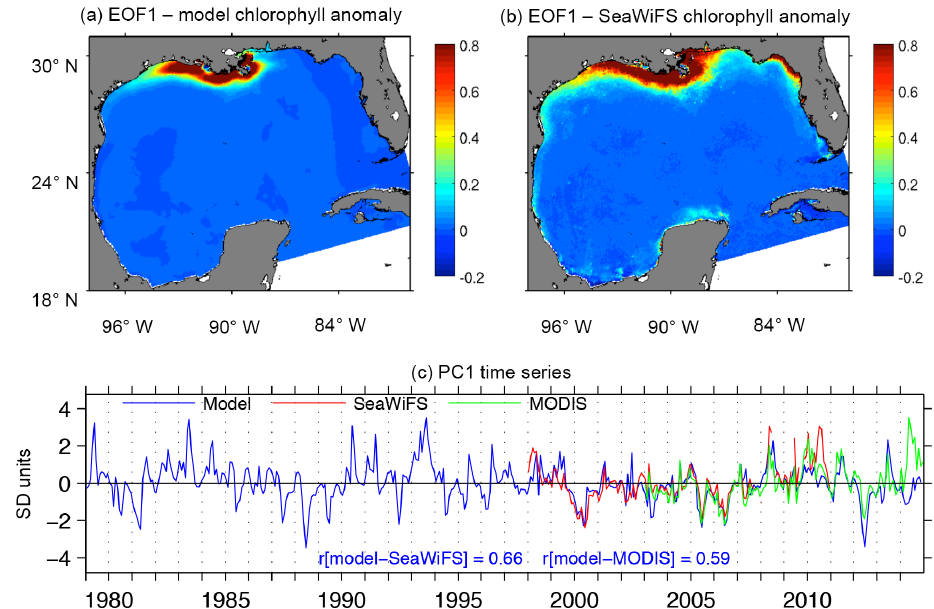
Figure 4. EOF analysis of chlorophyll anomalies. (a, b) First EOF mode of surface model chlorophyll (a) and SeaWiFS chlorophyll (b) . (c) Principal component associated with the first EOF mode of model, SeaWiFS, and MODIS chlorophyll. Correlation coefficient between model and satellite PC1 series is indicated in (c)